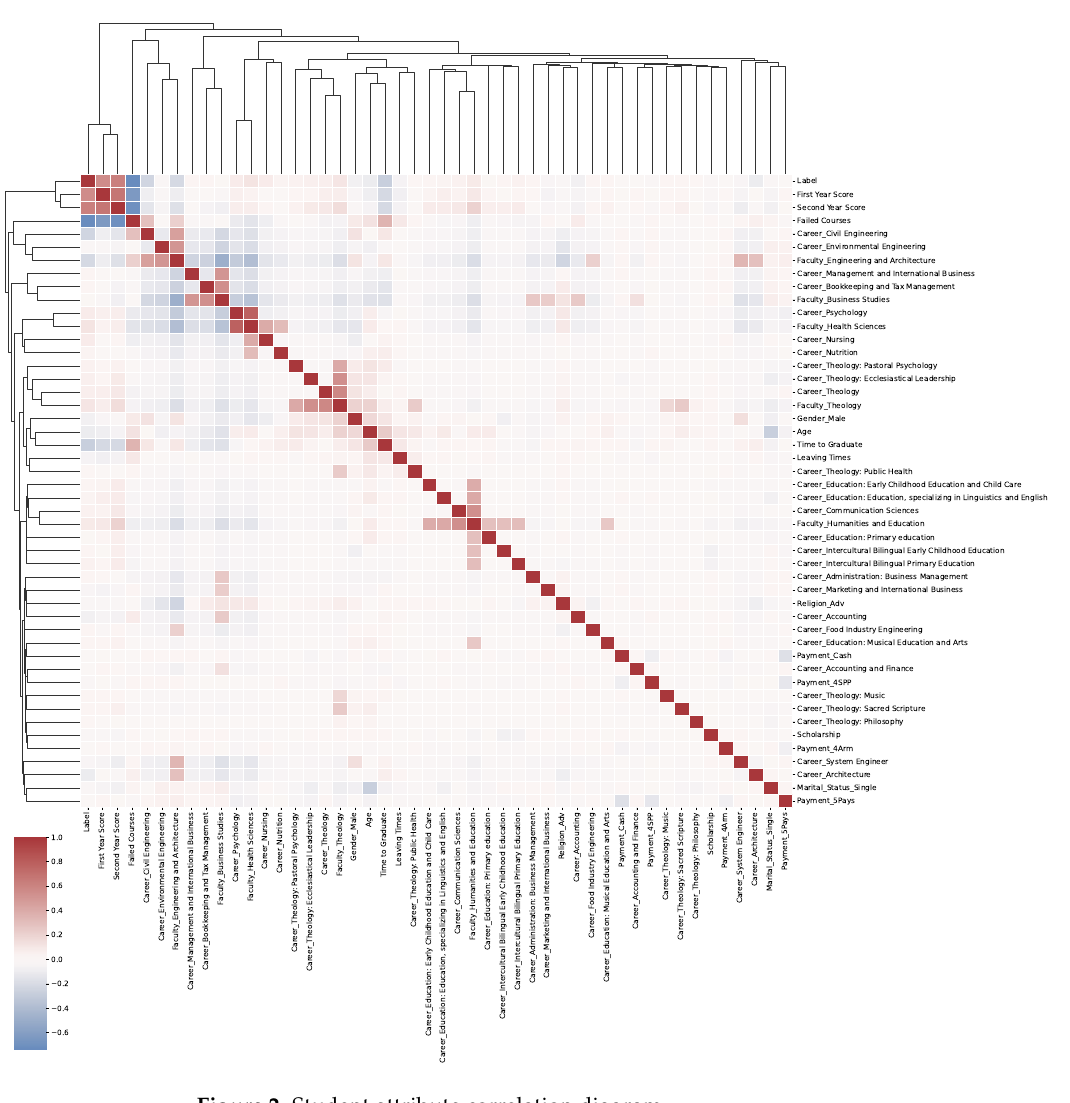
Figure 2. Student attribute correlation diagram.